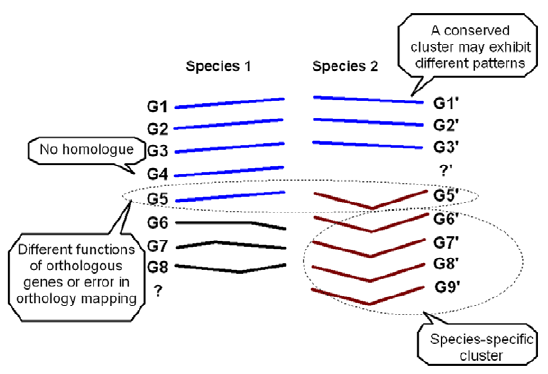
Figure 1. Major features and assumptions of the SCSC method. 1. G1–G8 are eight genes in Species 1, which have orthologues G1 9 –G8 9 in Species 2. 2. G4 and G9 9 do not have orthologues, but they participate in the clustering analysis. 3. The shapes of the lines represent gene expression patterns. For example, G1 has an increasing pattern and G6 9 has a first decreasing and then increasing pattern. 4. The genes with the same color, except for the black color, are clustered together. Genes in black are ‘‘scattered’’ genes, which form a singleton cluster each.